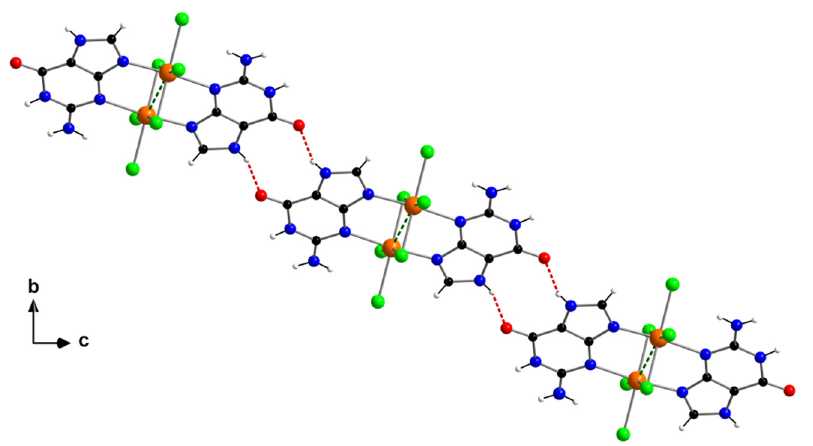
Figure 3. View along the crystallographic a axis of a fragment of the crystal packing of 1 . H-bonding interactions between O atoms and N-H groups of adjacent [{Ru(µ-Cl)(µ-gua)} 2 Cl 4 ] units are shown as red-dashed lines. Water molecules have been omitted for clarity.